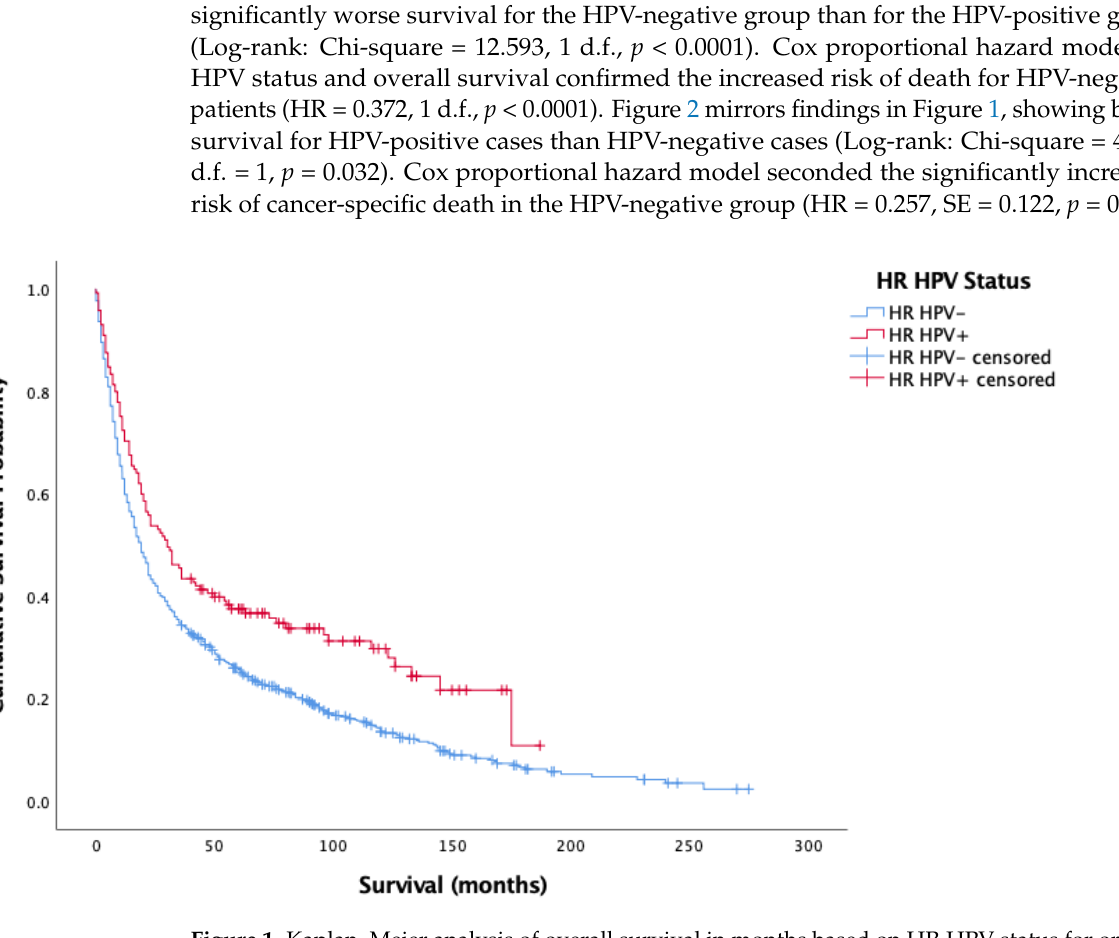
Table 5. HPV DNA prevalence for oropharyngeal, oral cavity, and laryngeal cancer diagnosed in Ireland between 1994 and 2013.